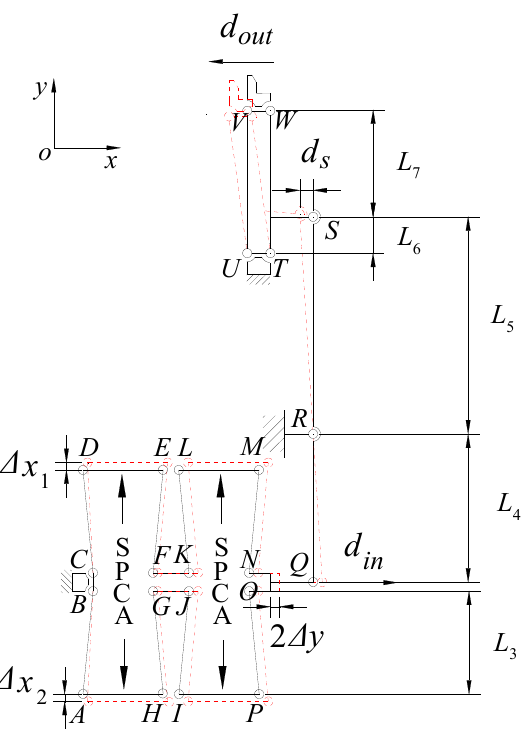
Figure 2. Pseudo rigid body model of the PZT driven microgripper.